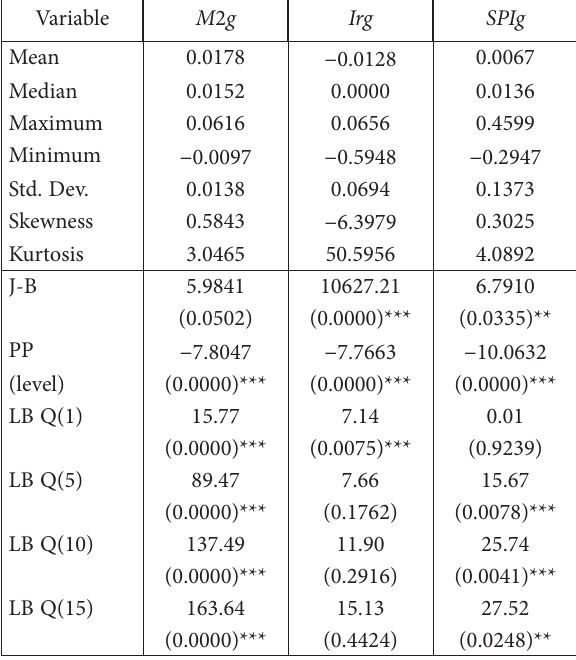
Table 2. Descriptive statistics and tests of macroeconomic